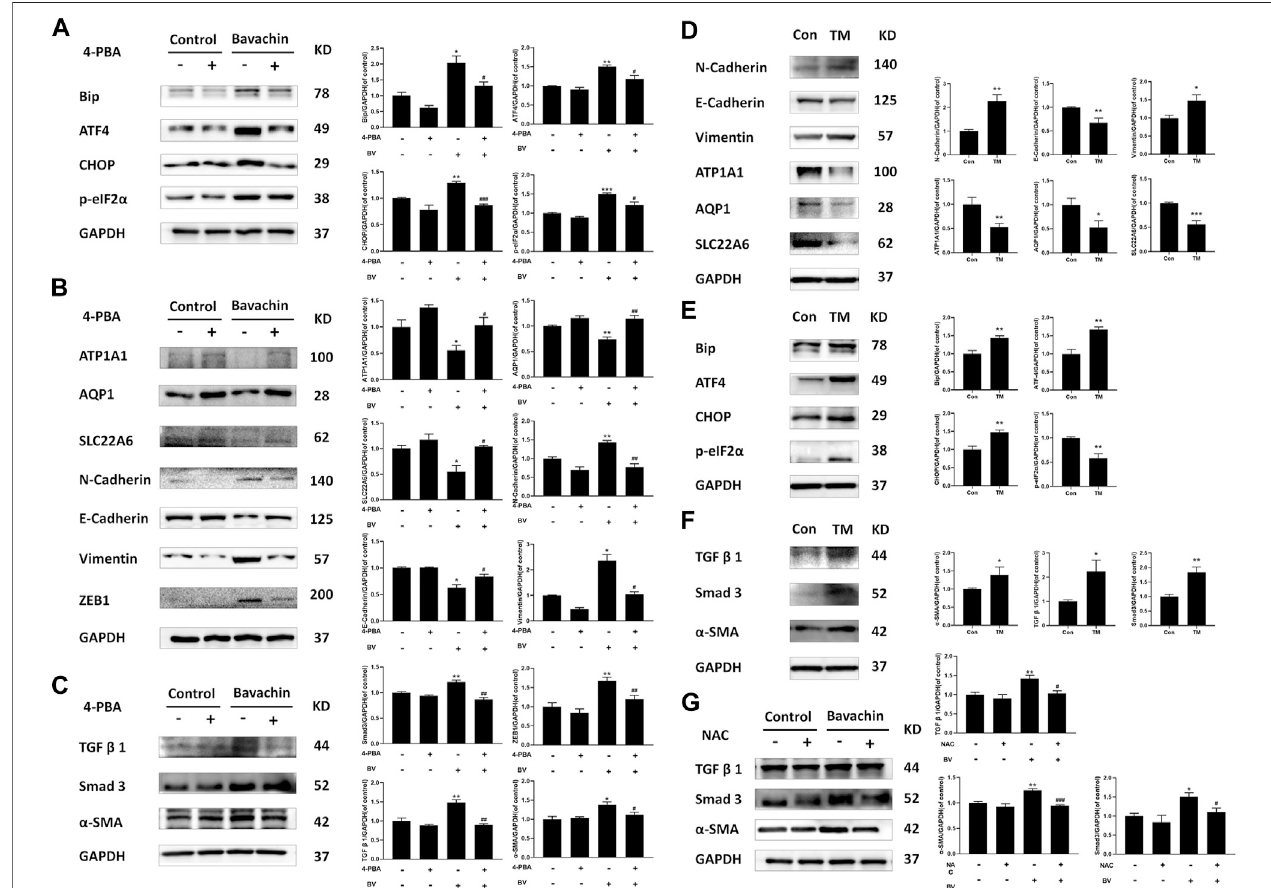
FIGURE4| InhibitionofROS-mediatedERstressreversed BV-triggeredEMT and pro fi brotic signaling. After24 h BVtreatment with/without4-PBA co-treatment, the expressions of ER stress (A) , EMT (B), and fi brosis-related (C) proteins were examined by western blot. (D – F) The expressions of indicated proteins in TM-treated HK2 cells. (G) BV-induced pro fi broticsignaling inNACcotreatedHK2cellswasdetected.* p < 0.05,** p < 0.01,and *** p < 0.001 vs.thecontrolgroups. # p < 0.05, ## p < 0.01, and ### p < 0.001 vs. the BV-treated groups.